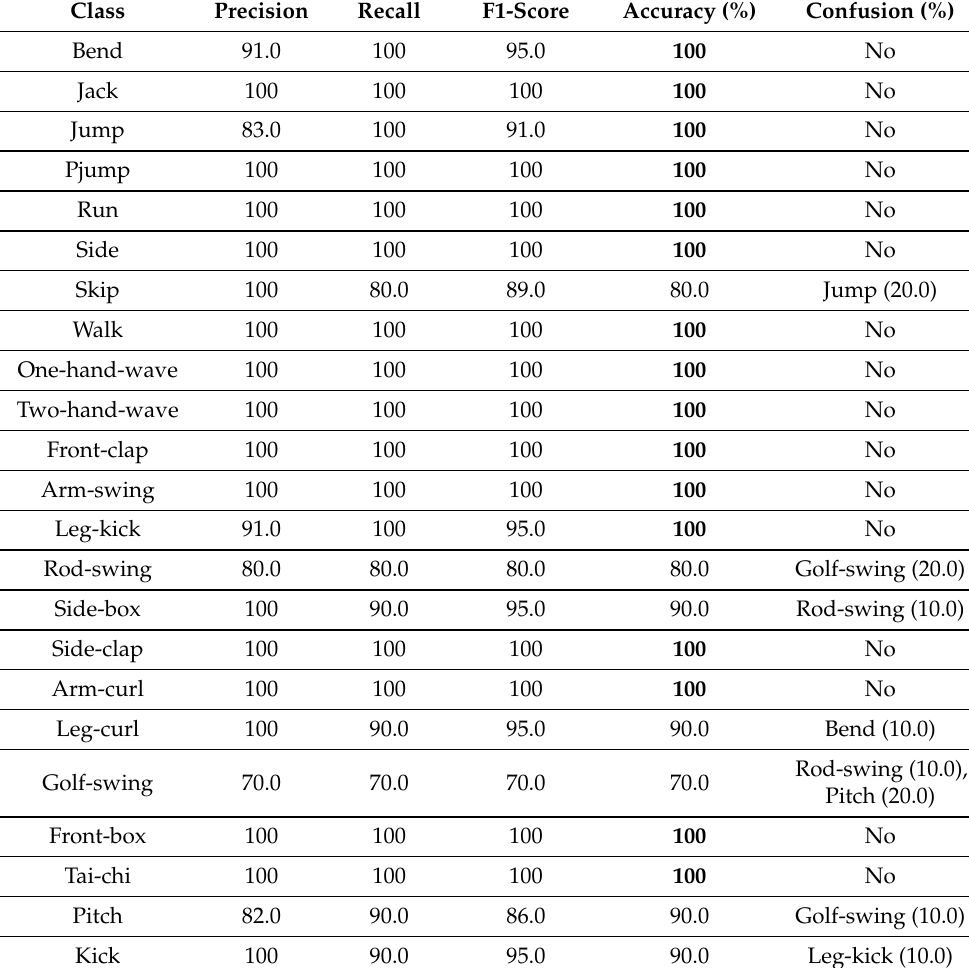
Table 4. Class-specific comprehensive classification report on DHA test